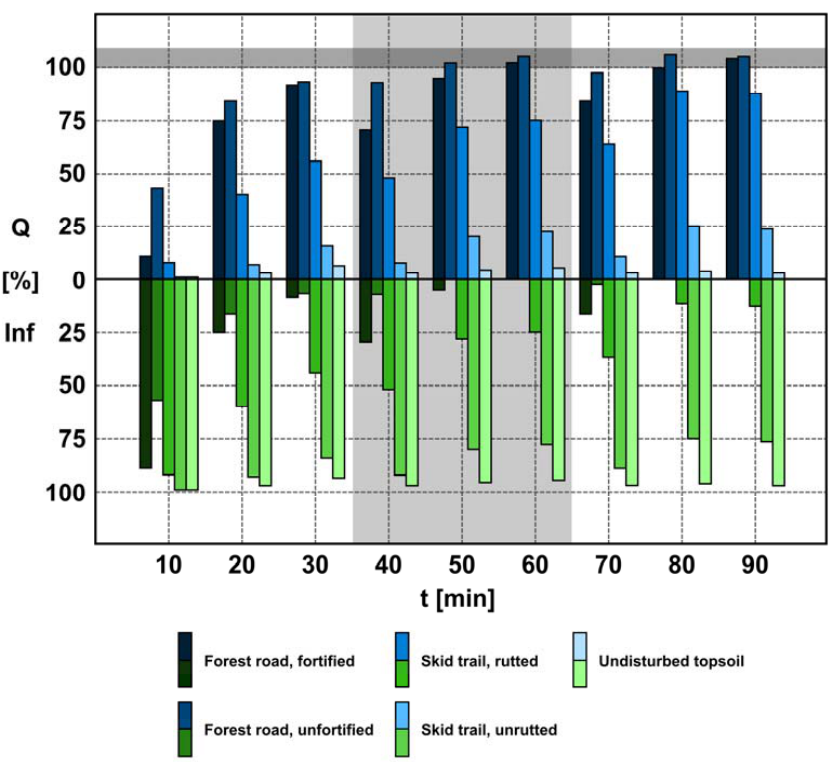
Figure 6. Mean runoff (Q) and infiltration (Inf) percentages for each surface category, time interval 10 min (t).